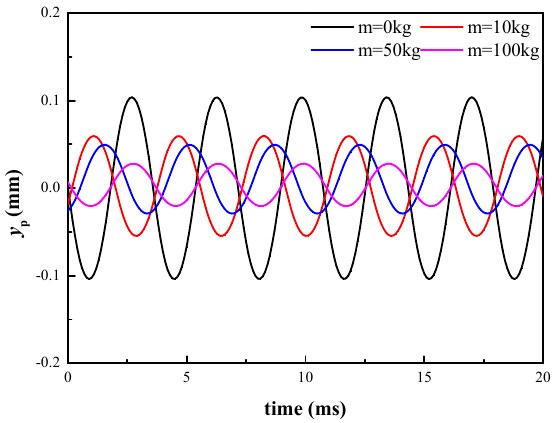
Figure 33. Displacements of different loads.